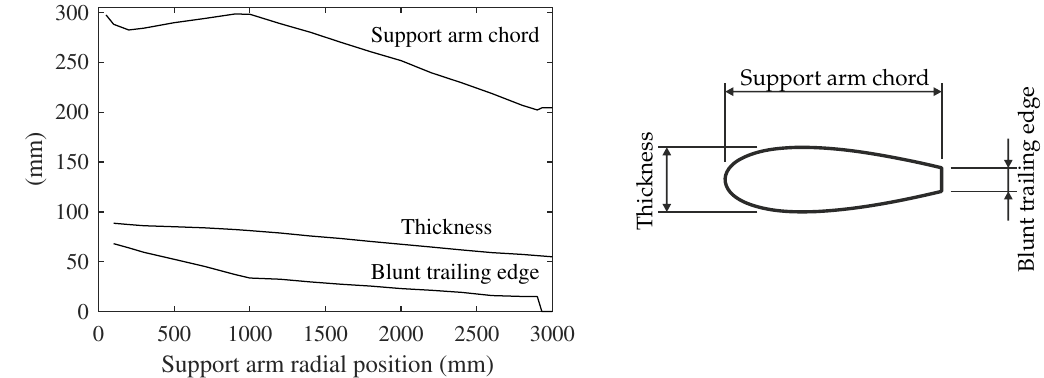
Figure 2. The support arm design is based on a NACA0025 profile, but where the upper and lower halves have been separated at the trailing edge, causing a blunt trailing edge. Left: How the dimensions of the support arms vary with radial position. Zero radial position represents the start of the support arm, which is attached 0.3m from the turbine axis. Right: Cross-section of the support arm with the specification of the varying